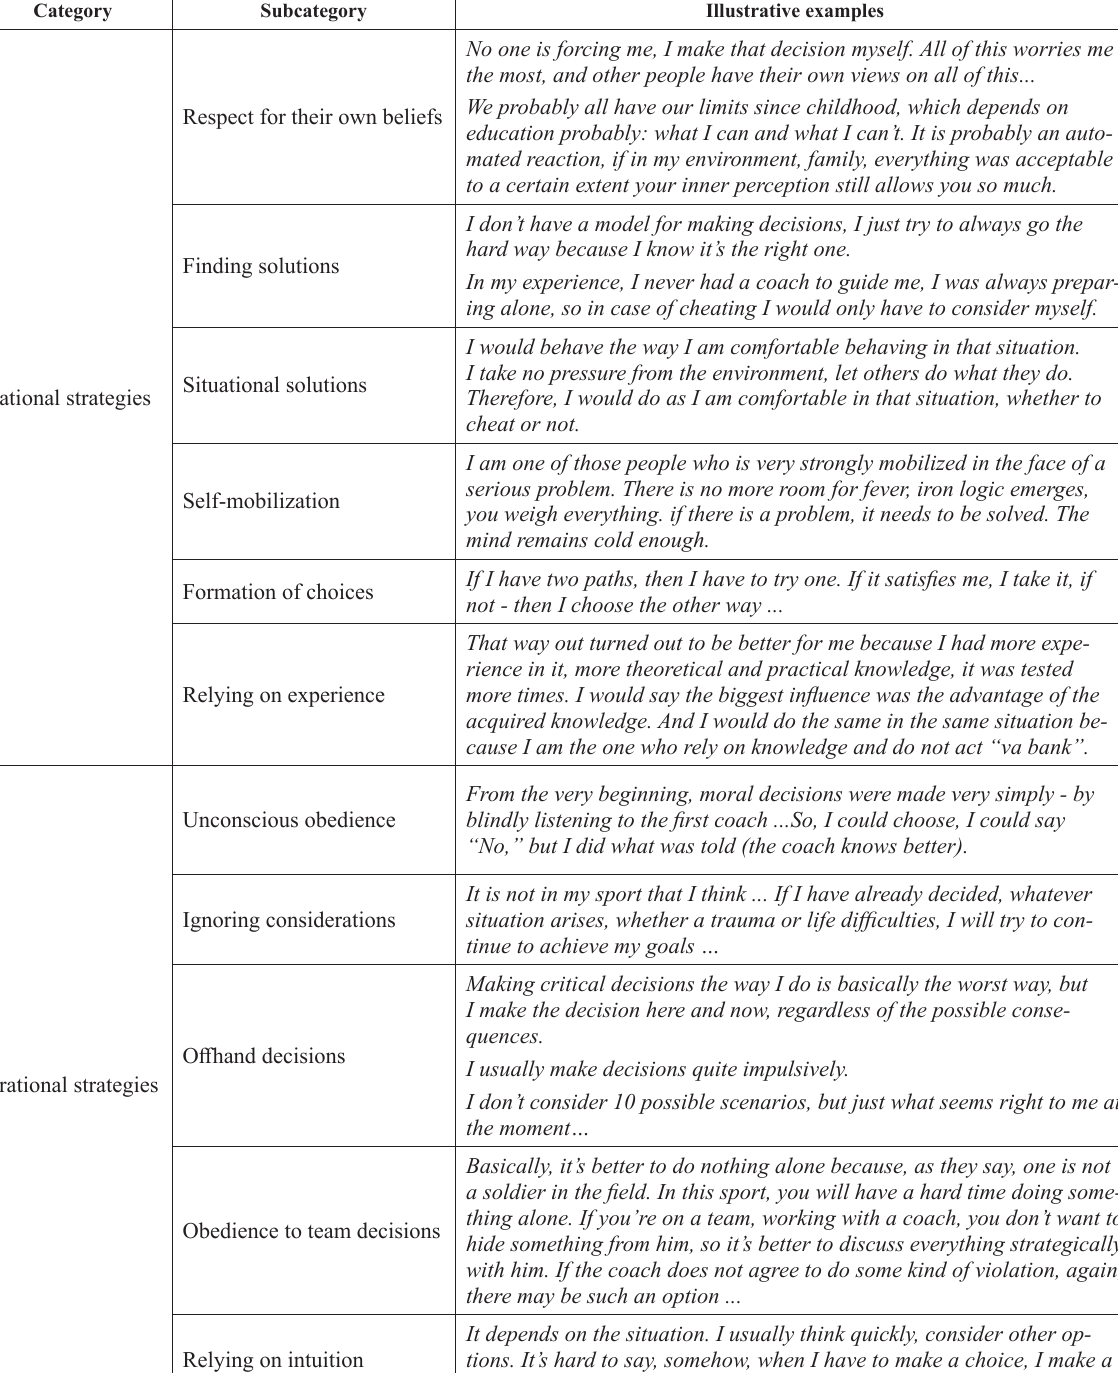
Table 6. Moral reasoning strategies